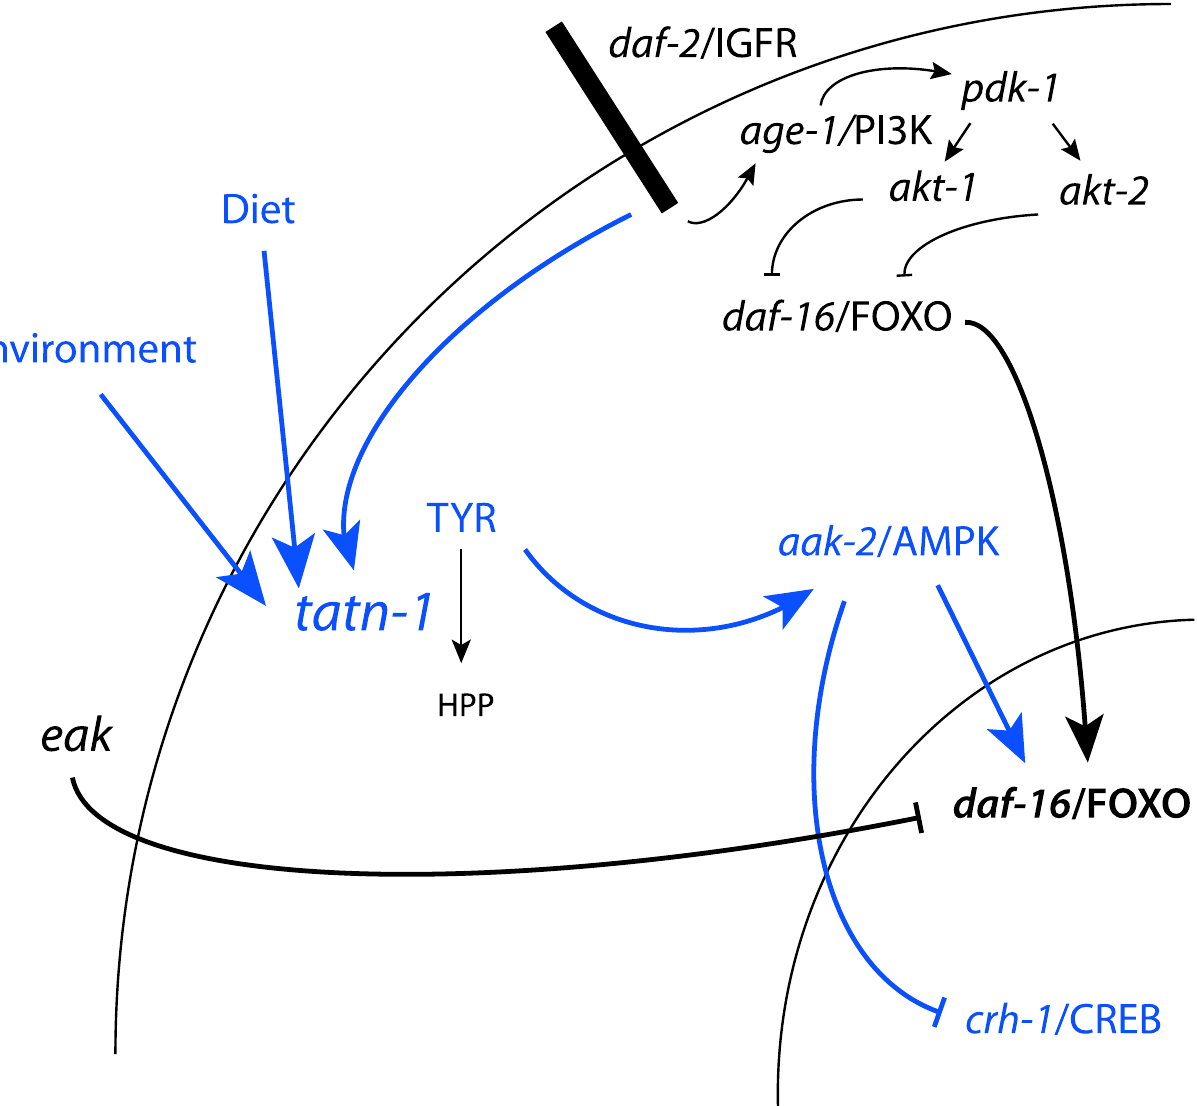
Figure 10. Model for the regulation of TATN-1 expression, tyrosine levels, and the resulting effects of tyrosine effects on cell signaling pathways. Shown is the daf-2 /IGFR signaling pathway and eak genes from Figure 1A with the addition, shown in blue, of the effects of tyrosine identified in this work and the control of TATN-1 expression by daf-2 /IGFR signaling and by dietary and environmental cues as demonstrated in Figure 8. In summary, worms sense the available diet and environmental temperature and these factors both contribute to the dauer decision and the regulation of TATN-1 protein levels. Conditions which promote the dauer decision also tend to reduce the expression of TATN-1. The reductions in TATN-1 expression lead to reduced removal of tyrosine through degradation and increase free tyrosine levels in the animal. These increases in tyrosine activate aak-2 /AMPK and disrupt the effects of normal daf-2 /IGFR signaling through positive effects on daf-16 /FOXO and perhaps inhibitory effects on crh-1 /CREB. The effects of tyrosine are particularly pronounced when the daf-2 /IGFR pathway is compromised, such as through mutations in the daf-2 /IGFR gene or the eak genes which lie in a parallel pathway. This may be due to further reductions in TATN-1 expression or reductions in inhibitory regulators of daf-16 /FOXO